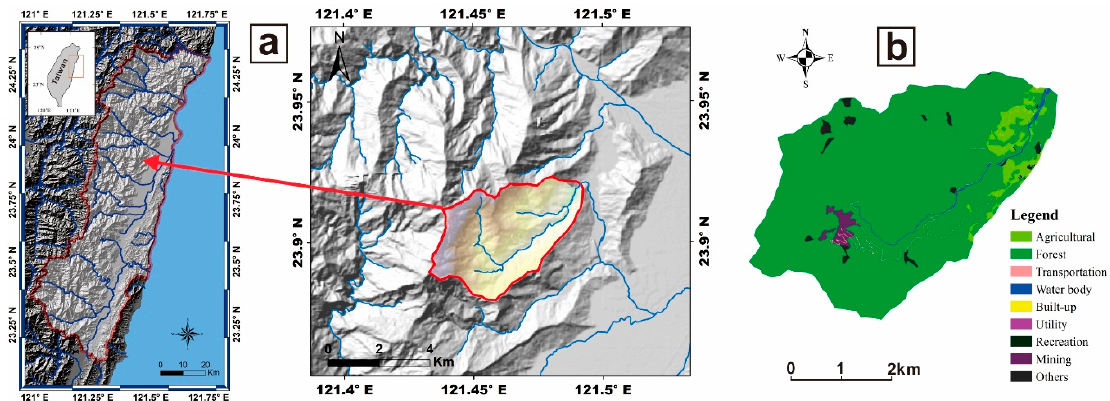
Figure 1. The study area. ( a ) Topography and river systems in the Hualien area [40]; ( b ) land use of the Chinan area.